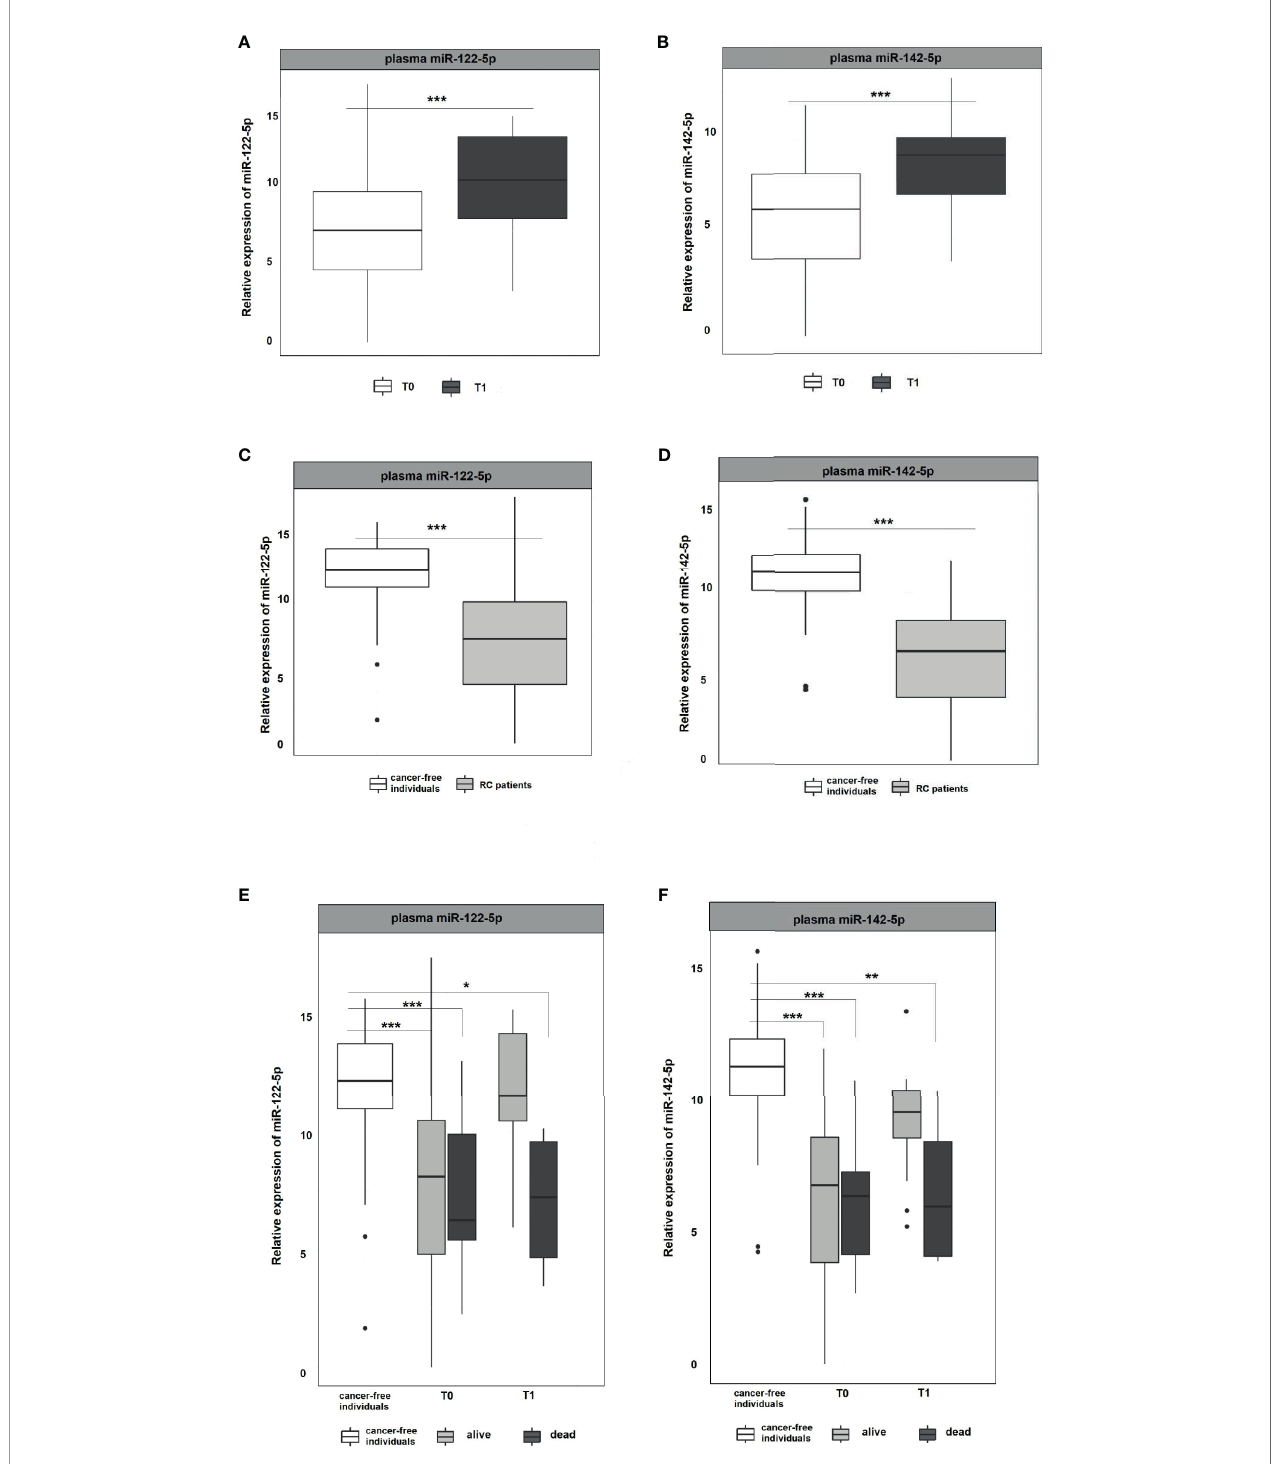
FIGURE 2 | Expression analysis of miR-122-5p and miR-142-5p in plasma. (A, B) The expression levels of miR-122-5p and miR-142-5p were signi fi cantly lower at the 1 st plasma sampling (T0) compared to 2 nd sampling (T1) of RC patients (miR-122-5p: p=0.0003, 3.2-fold change; miR-142-5p: p=0.0002, 2.4-fold change). (C, D) Expression levels of miR-122-5p and miR-142-5p were signi fi cantly lower in plasma from RC patients compared to the plasma of cancer-free individuals (for all p <0.001). (E, F) A year from the diagnosis (2 nd sampling, T1), a signi fi cant difference was observed between patients that do not respond a year after diagnosis and cancer-free individuals (miR-122-5p: plasma: 4.9-fold change, p=0.05; miR-142-5p: plasma: 4.5-fold change, p=0.008). *p ≤ 0.05, **p ≤ 0.01, ***p ≤